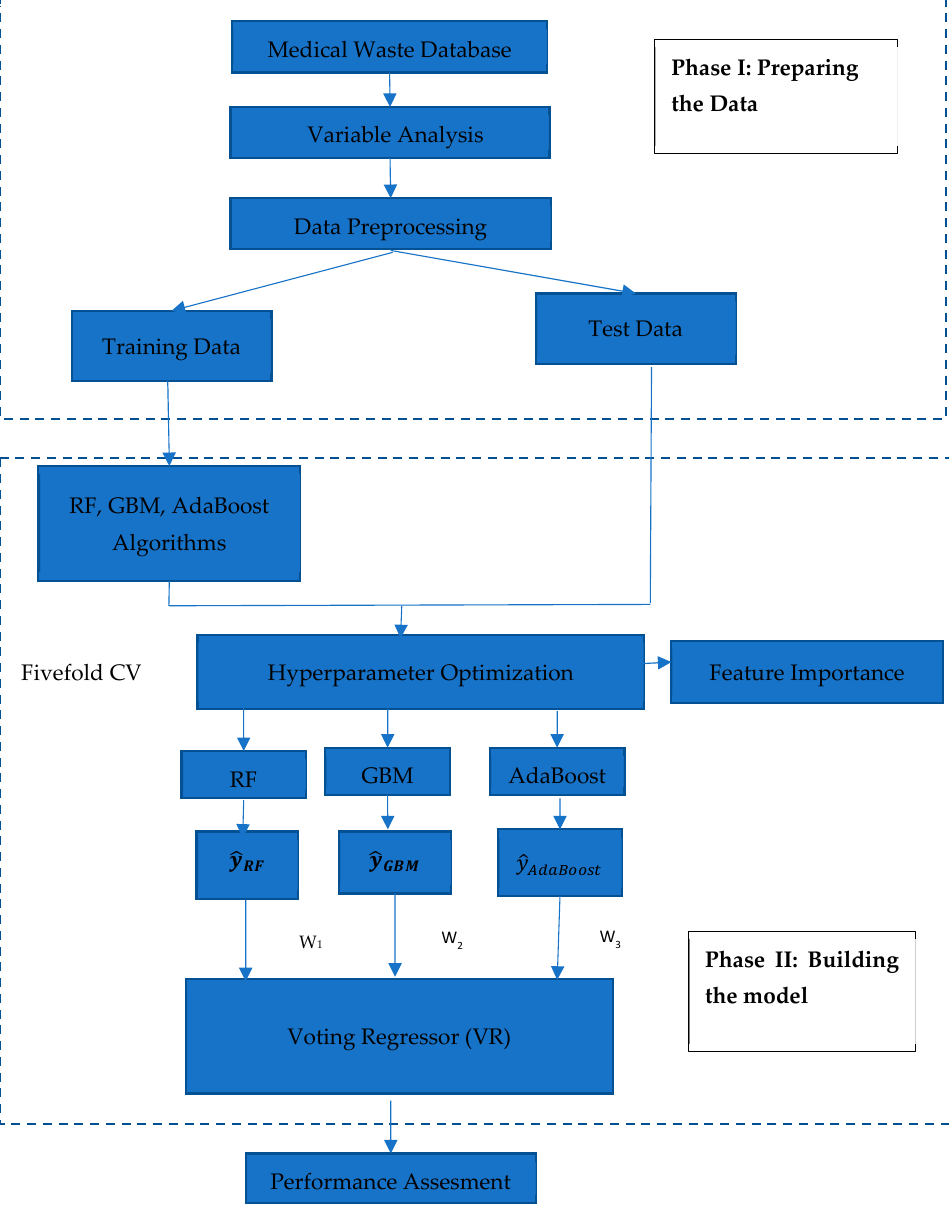
Figure 1. The process of the proposed model.